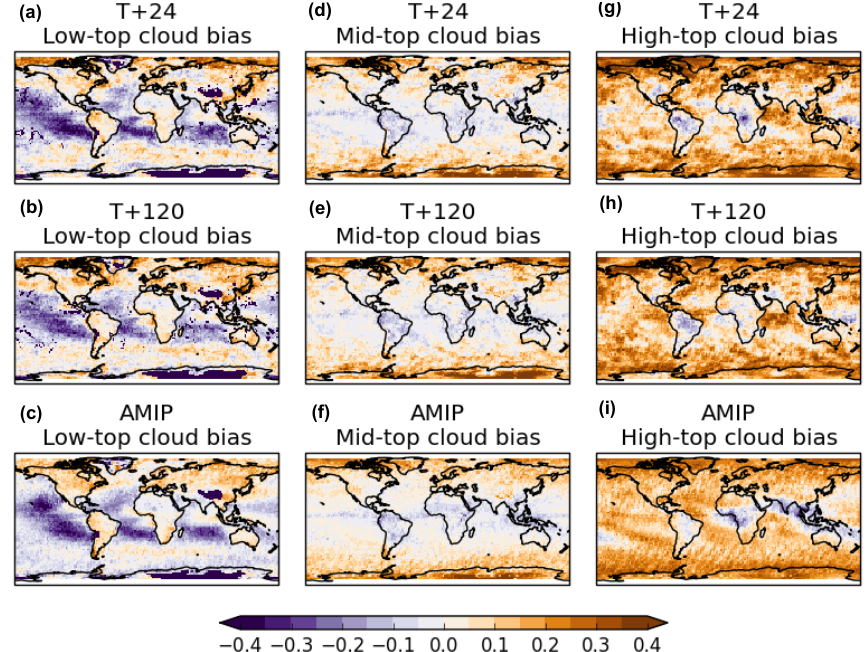
Figure 1. Absolute bias (model field minus observed field) in GA6 configuration of the UM for low (a–c) , mid- (d–f) and high (g–i) fractional cloud cover against the GCM-oriented CALIPSO cloud product (GOCCP), using the CALIPSO simulator in COSP (see Sect. 2.2). Panels (a) , (d) , (g) and (b) , (e) , (h) show mean biases at day 1 and day 5 averaged across all the NWP hindcasts at N320 (40km in mid-latitudes) resolution. Panels (c) , (f) , (i) show the bias in the AMIP climatology at N96 (135km in mid-latitudes)